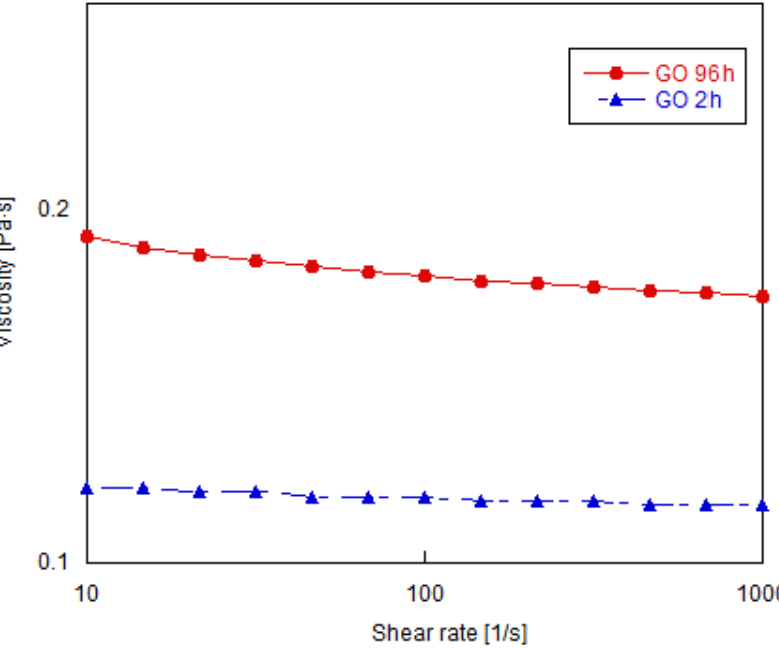
Figure 10. Flow curve comparing viscosity for suspensions with 40 mg/mL of GO with different oxidation times.